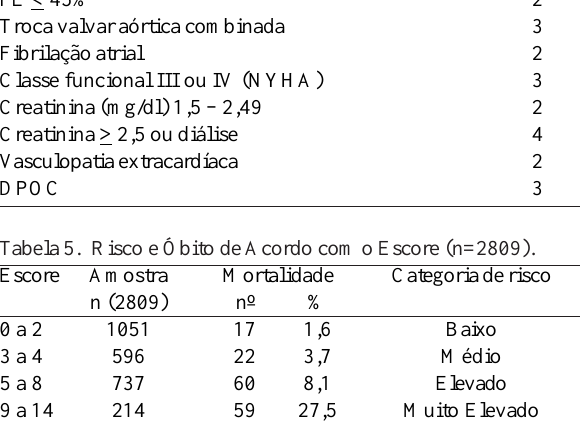
Fig. 1 - Área sob a curva ROC na detecção da ocorrência de óbito h = 0,86 (IC 95%: 0,81 – 0,9) no Modelo de Risco Final